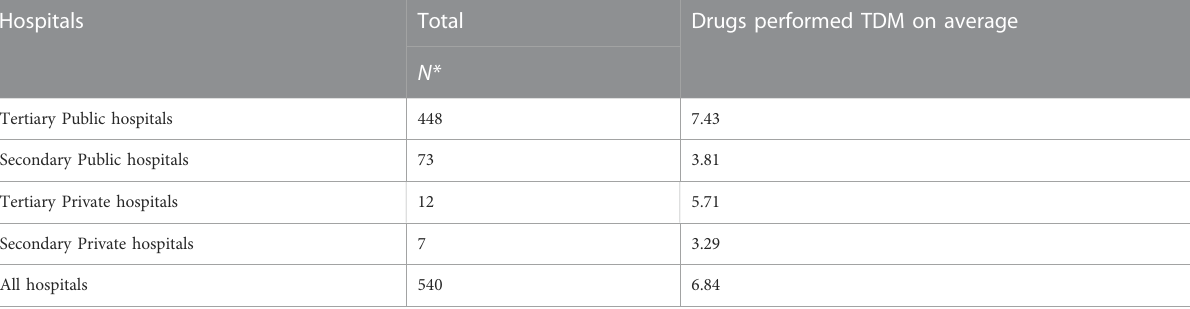
TABLE 3 Drugs performed TDM on average in 540